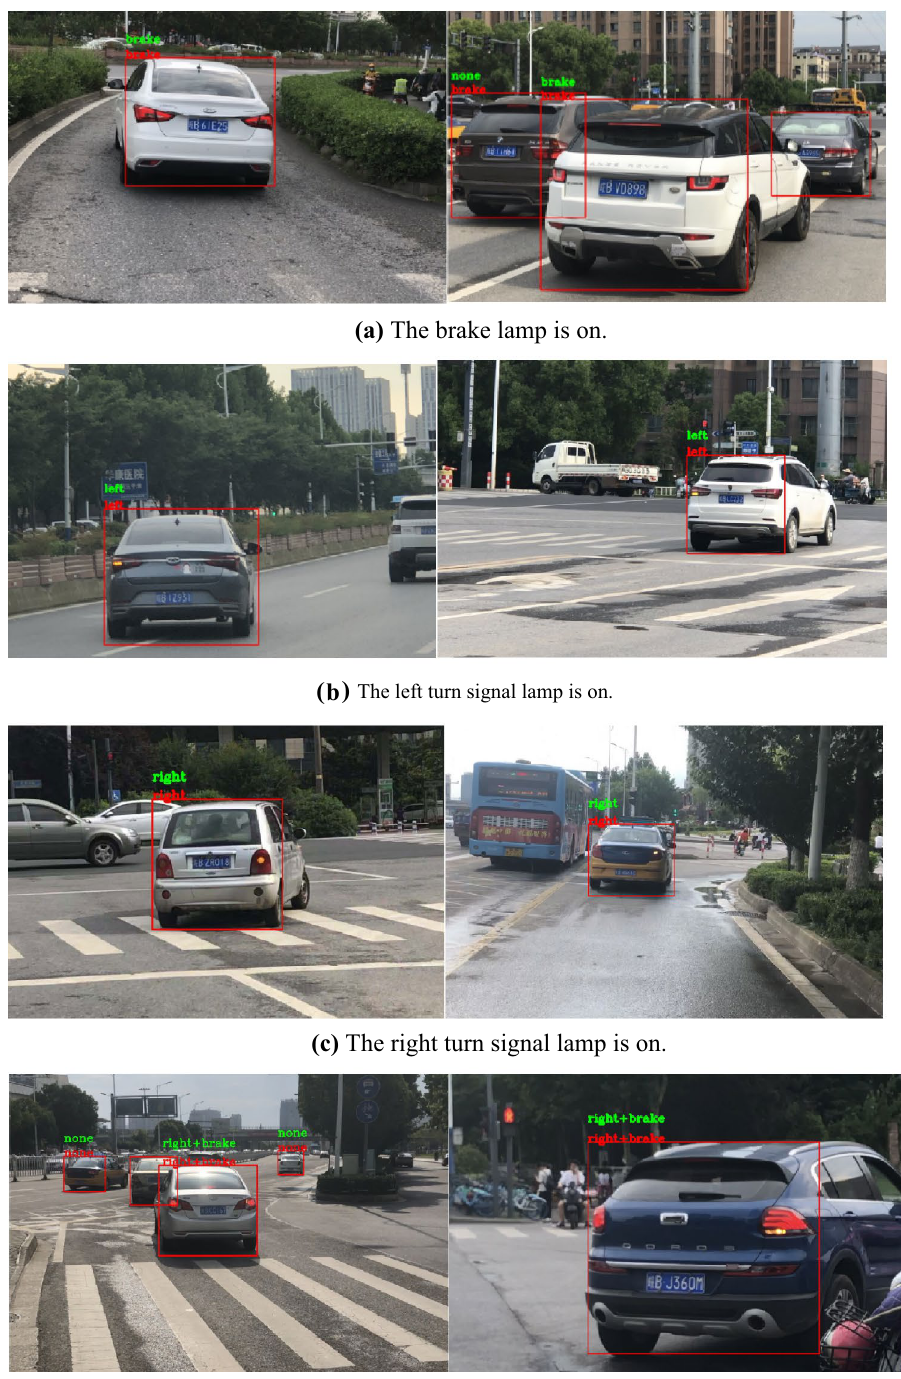
(d) The brake lamp and turn signal lamp are on at the same time.